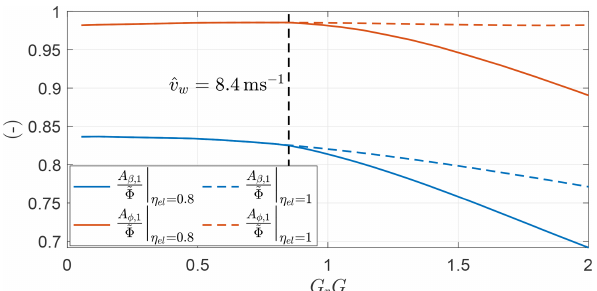
Figure 39. Optimal values of A β, 1 and A φ, 1 normalized with the analytical expression of the opening angle ˜ (cid:56) for a case with η el = 0 . 8 ( − ) and η el = 1 ( − − ) as a function of G r G